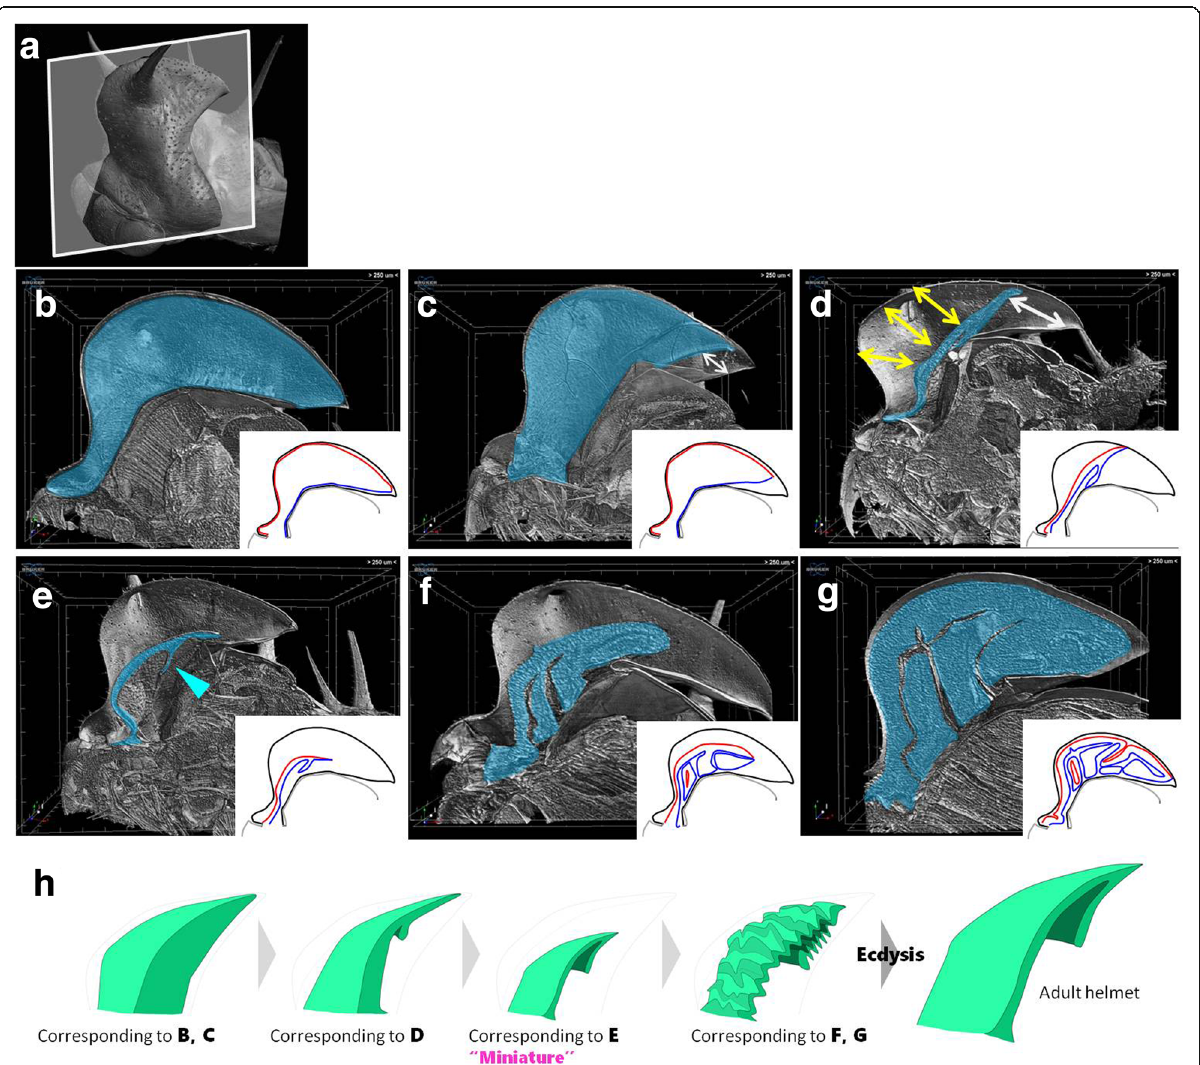
Fig. 5 Helmet morphogenesis inside the nymphal helmet sheath in Antianthe expansa. a Surface view of last instar nymph of Antianthe expansa via micro CT scan. White window indicates sectioned region in B to G. b - g Sagittal section of last instar nymph. The developing adult helmet primordium is highlighted in blue. Schematic diagrams of developing helmet are shown in small windows in each panel. Black lines, red lines and blue lines indicate nymphal cuticle, upper layer and lower layer, respectively. b At an early stage of the last instar nymph (before apolysis), the helmet was a monolayer, sac- like structure. c Once apolysis started, the helmet epithelium detached from the nymphal cuticle. First, the lower layer of most posterior region detached, indicated by a white arrow. d Both upper and lower layer detached from the nymphal cuticle (yellow arrows and white arrow) and came together to form a thin, double-layered plate-like structure. e Shrunken miniature of adult helmet has formed. At this stage a bi-layer septum also formed (blue arrowhead). f Miniature grows, probably by cell proliferation. During this stage both macro and micro furrows are developed. g Fully developed helmet primordium which fills the entire space of the helmet sheath. The bi-layer epithelial sheet is highly complex in three dimensions, so that it is difficult to understand its structure from a single section. h Schematic diagram of helmet development during the last instar